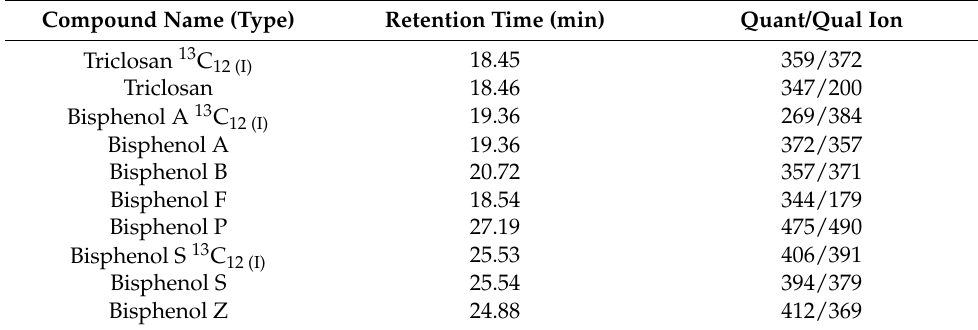
Table A2. GC/MS SIM